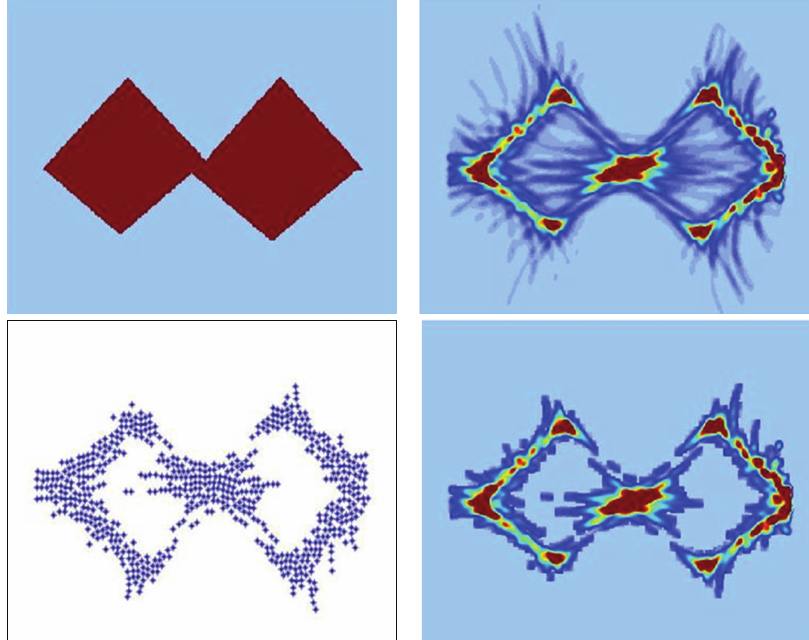
Figure 6: The original (a), SAR-processed (b), scattering centers (c), and CLEANed (d) images of a PEC object with a complex geometry. contour of the even complex images can be obtained by the feature extraction capability of the algorithm. The CLEAN technique can be used for two di ff erent purposes, and this strengthens the